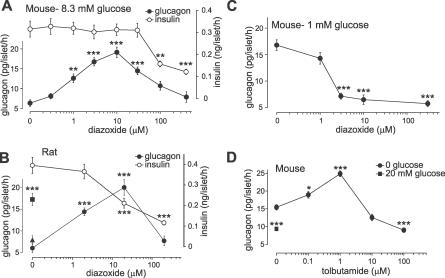
Glucagon Release from Isolated and Intact Mouse Islets Is Regulated by a KATP Channel-Dependent Pathway(A) Glucagon (filled circles) and insulin (open circles) secretion measured from mouse islets in the presence of 8.3 mM glucose at increasing concentrations of diazoxide.(B) As in (A), but using rat islets. The glucagon responses to 1 mM glucose (filled square) and 100 μM tolbutamide (filled triangle) are indicated.(C) As in (A), but in the presence of 1 mM glucose and only measuring glucagon secretion.(D) As in (A), but examining the effect of tolbutamide in the absence of glucose. Glucagon secretion in response to 20 mM glucose is indicated by the filled square.*, p < 0.05; **, p < 0.01; ***, p < 0.001, compared with zero diazoxide (A–C) or zero tolbutamide (D).